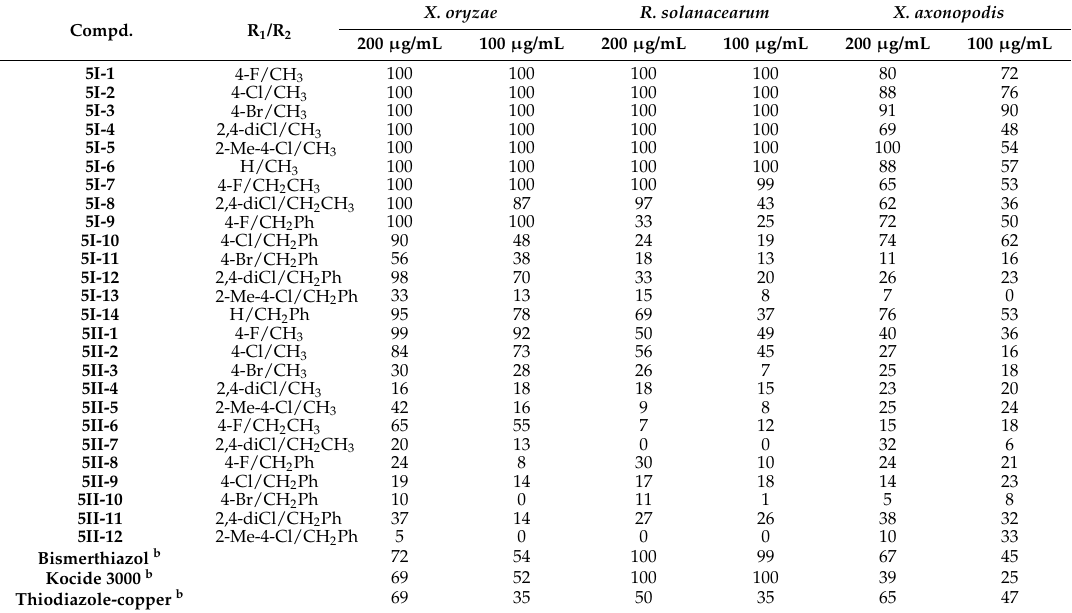
Table 1. Inhibition rate of Compounds 5I and 5II against Pathogenic Bacteria X. oryzae , R. solanacearum and X. axonopodis a